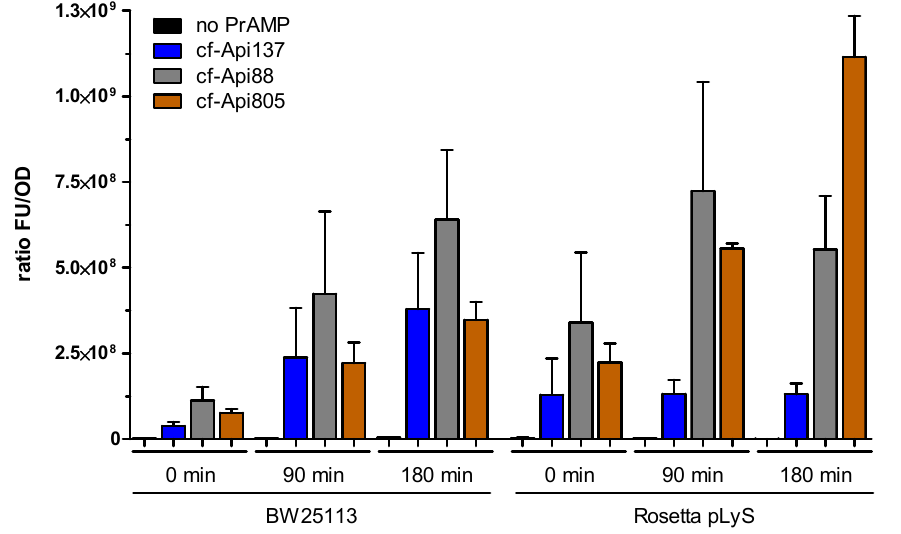
Figure 3. Uptake assay of E. coli BW25113 and Rosetta cultures incubated in the absence of PrAMP (black, negative control) or in the presence of cf-labeled Api137 (blue), Api88 (gray), and Api805 (orange) for 0, 90, and 180 min. Presented is the fluorescence remaining in the E. coli cells after washing them twice with PBS normalized to the OD 600 of the corresponding cell culture. The peptide concentration was 23 µmol/L. Experiments were performed twice in triplicate. Error bars indicate the standard deviation of all six replicates. Significant differences were determined using t -test (Table S6).